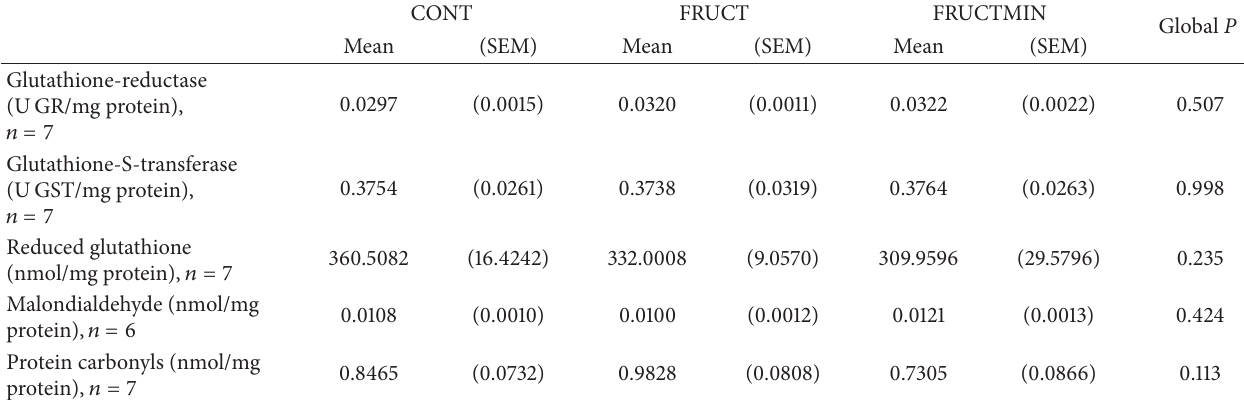
Table 4: Hepatic redox state characterization, at the end of the dietary intervention.